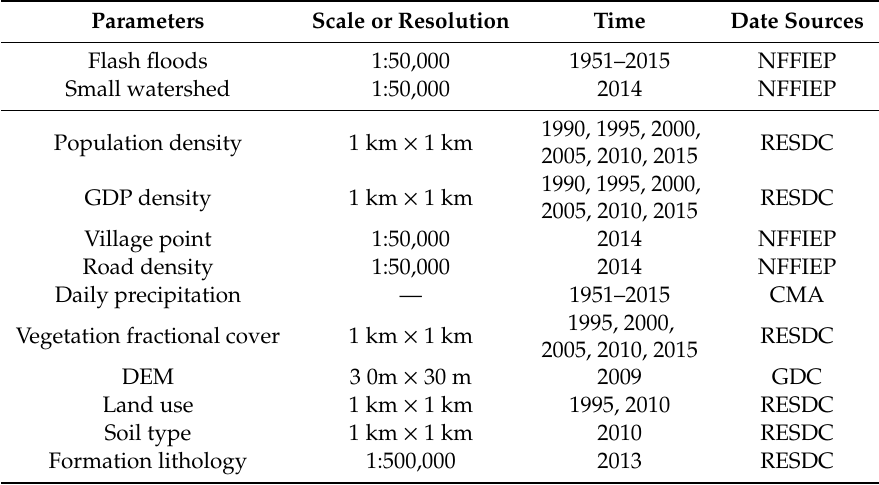
Table 1. List of data